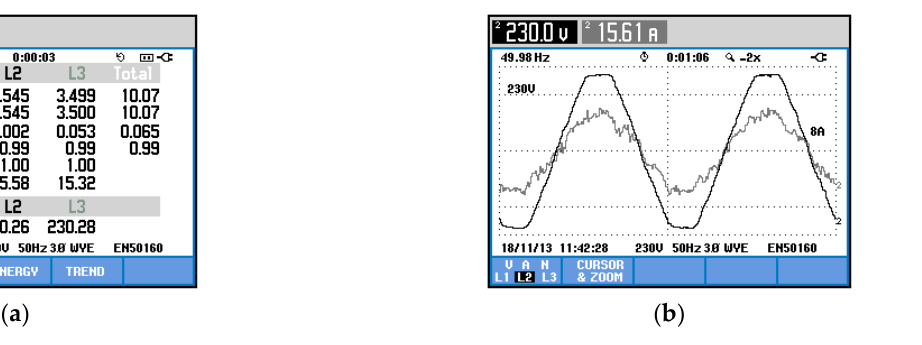
( c ) Figure 44. Case 6 - four-wire ShAPF operating with unbalanced loads: ( a ) three-phase voltages; ( b ) harmonic spectrum of the voltages; ( c ) harmonic spectrum of the voltage sequence components (maximum values). ( a ) ( b ) ( c ) Figure 45. Case 6 - four-wire ShAPF operating with unbalanced loads: ( a ) three-phase currents; ( b ) harmonic spectrum of the currents; ( c ) harmonic spectrum of the current sequence components (maximum values).